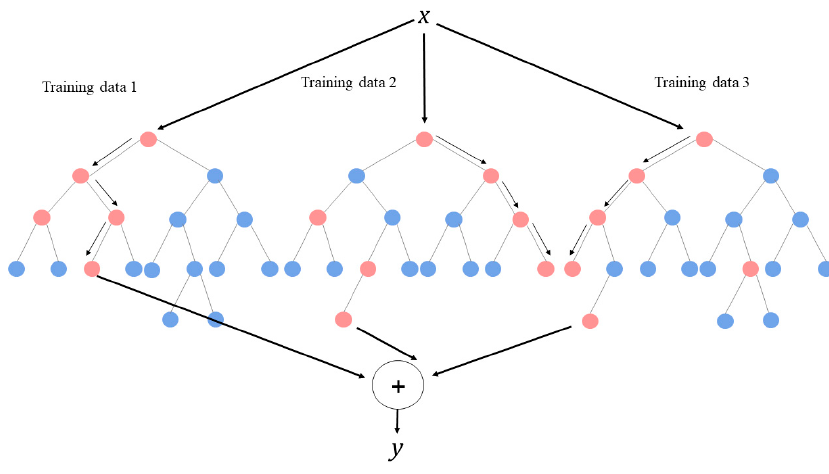
Figure 2. Classifier that combines many single decision trees .